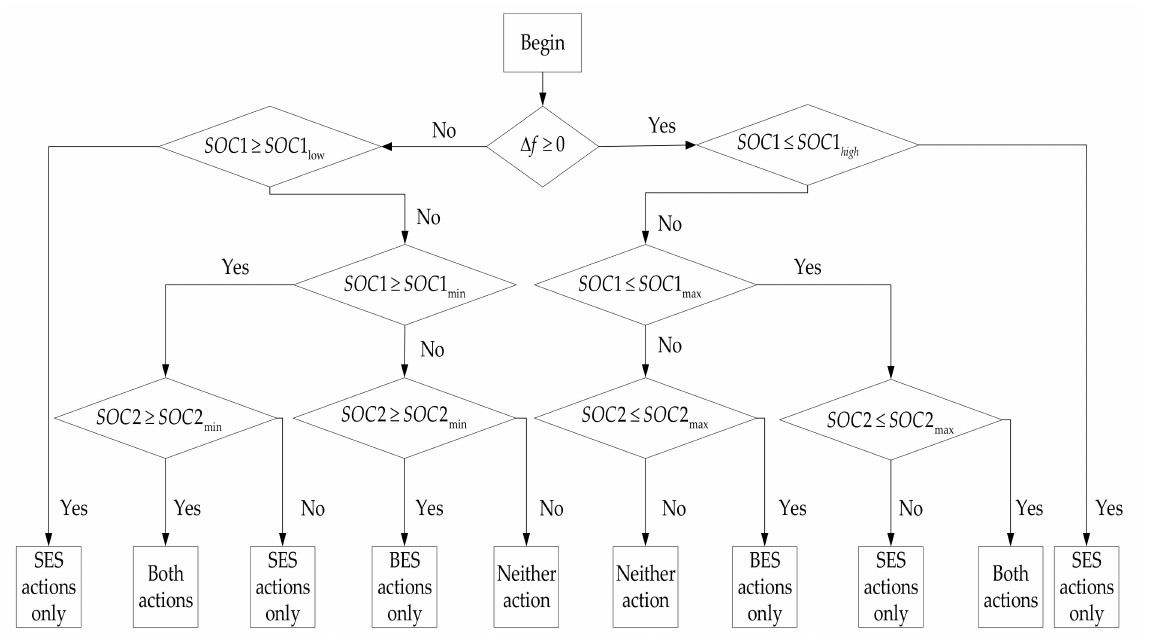
Figure 5. Selection strategies for different energy storage